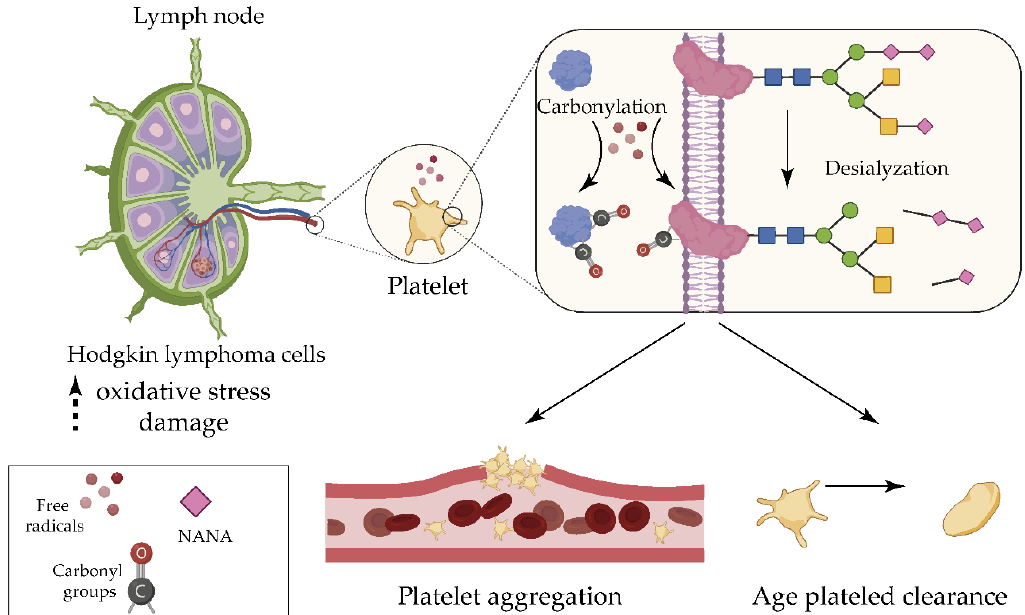
Figure 2. Protein carbonylation can induce membrane glycoprotein desialylation in platelets of patients with Hodgkin lymphoma. The level of sialic acid residues in platelets was found to be significantly lower and the carbonylation of proteins was higher in 10 cases of Hodgkin lymphoma compared with healthy controls [78]. A positive correlation was observed between the carbonylation of platelet proteins and the reduction in the content of N-acetyl neuraminic acid (NANA, a sialic acid residue) in platelet membrane glycoproteins, whose removal is involved in di ff erent physiological processes. The role of protein carbonylation in desialytation remains to be elucidated.